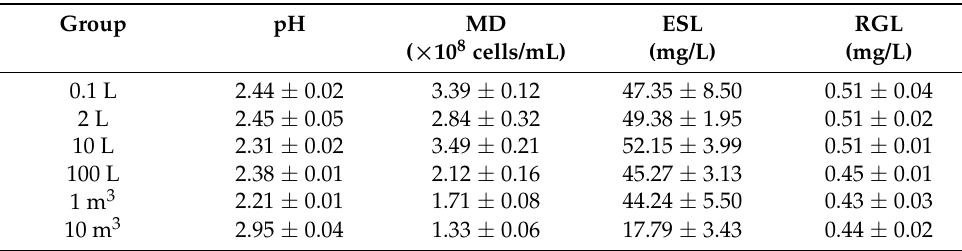
Table 2. Solution environmental factors of mixotrophic acidophiles in different scale-up cultivation stages.